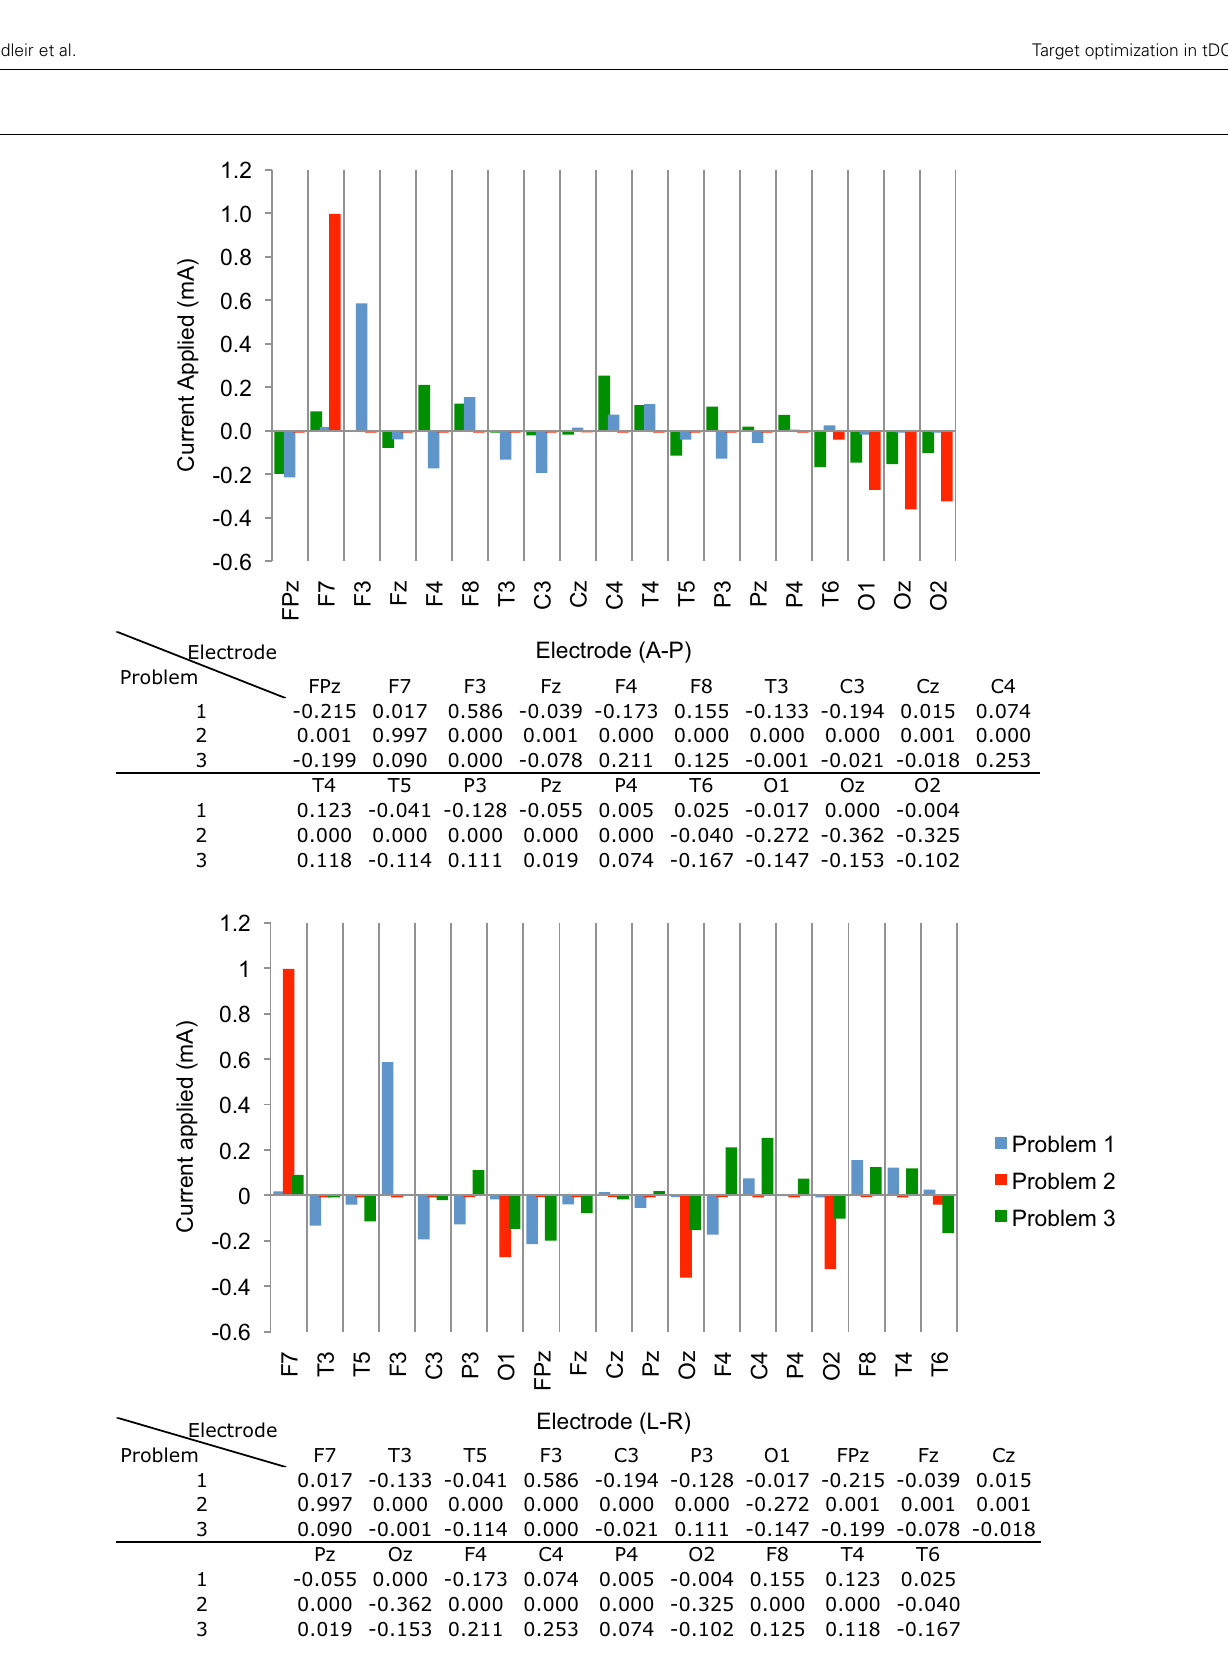
FIGURE 3 | Optimized current weights (in mA) found in the three problems, shown in graphical and tabular format. Weights are displayed in (top) Anterior-Posterior and (bottom) Left-Right arrangements.